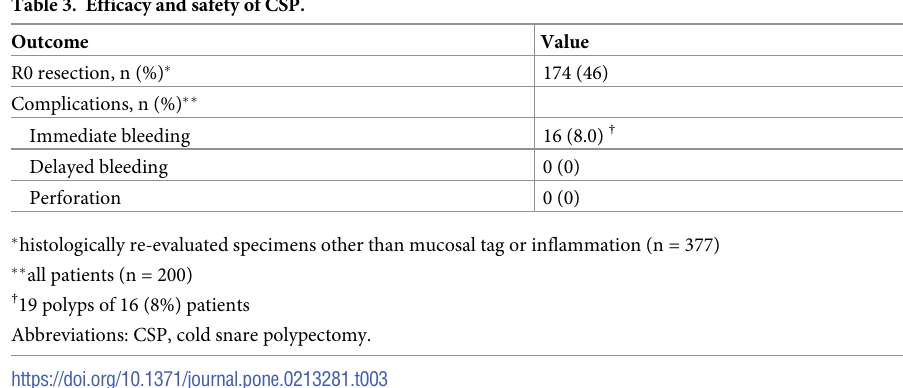
Abbreviations: NBI-M, narrow-band imaging with magnification.